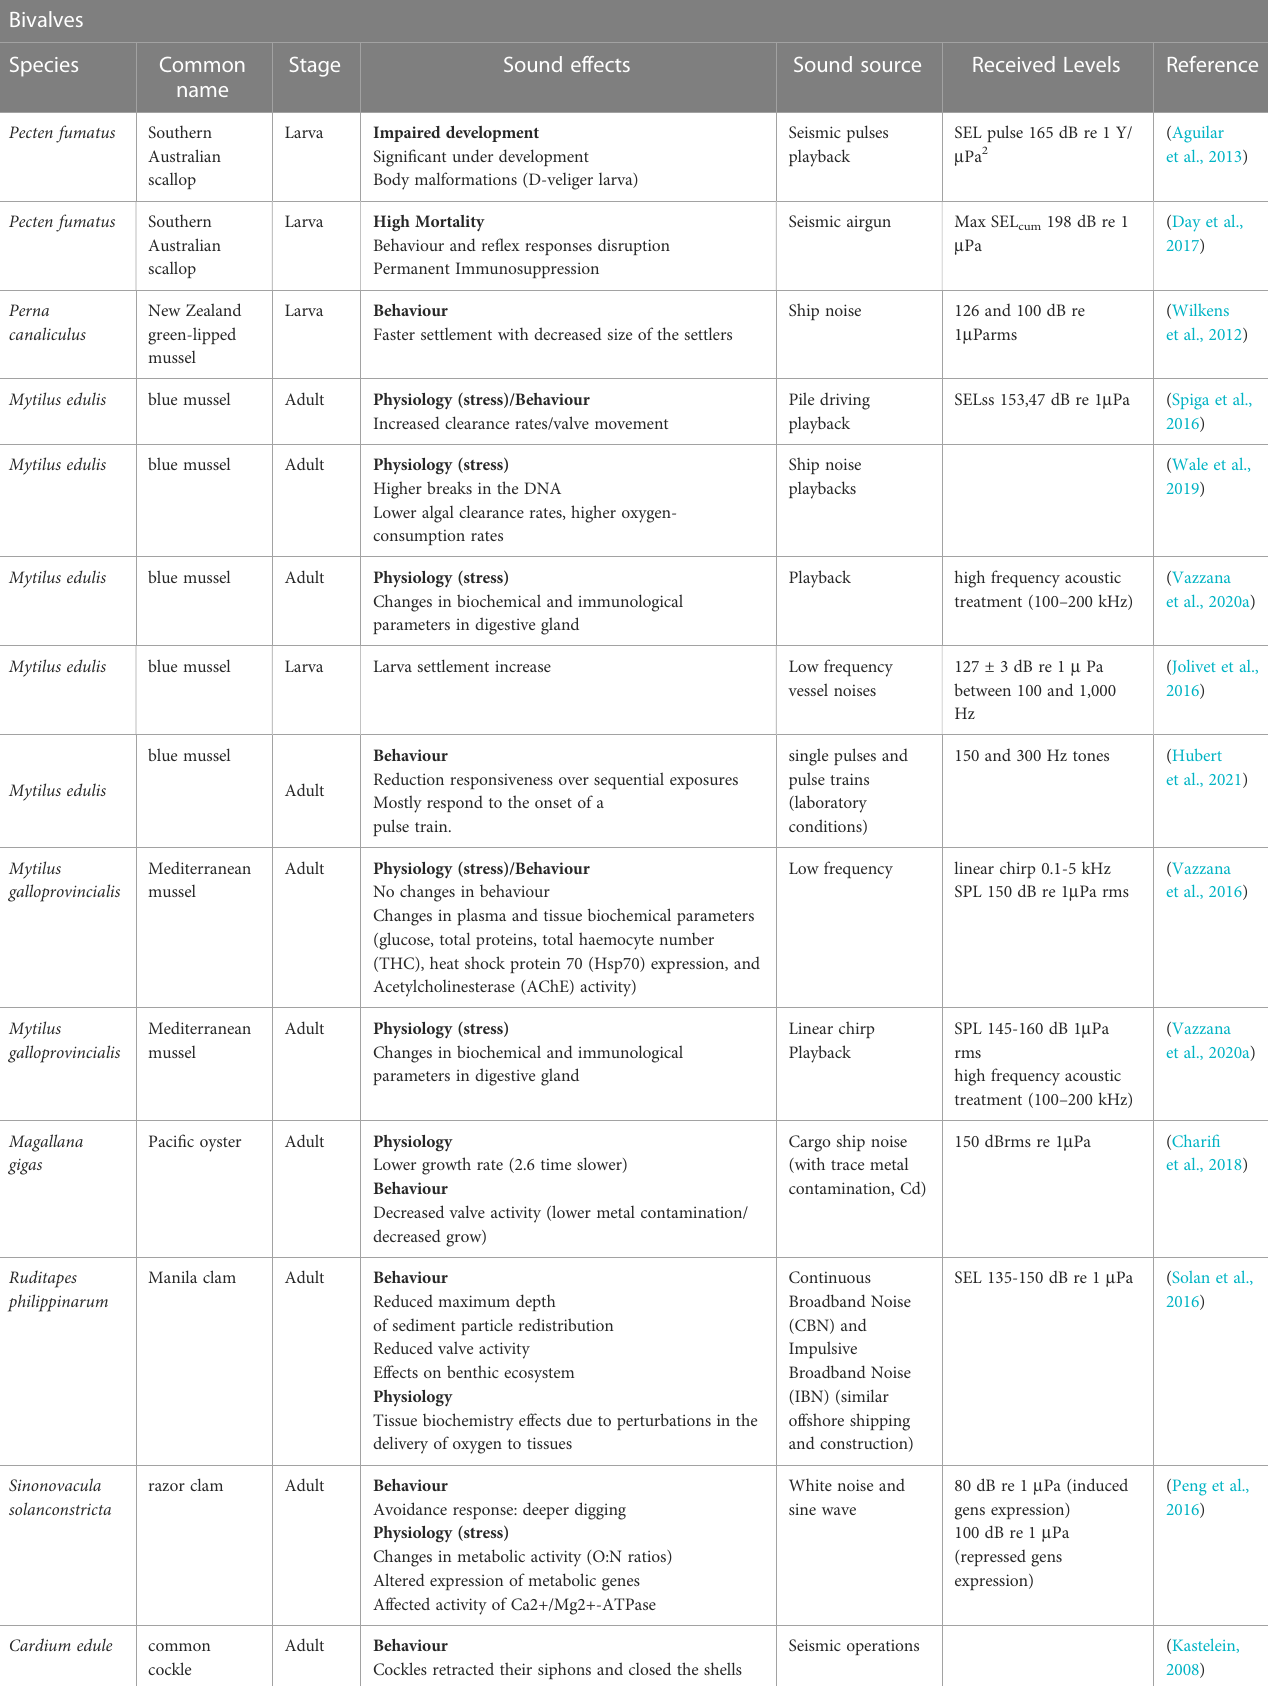
TABLE 4 Relevant studies on noise impact on